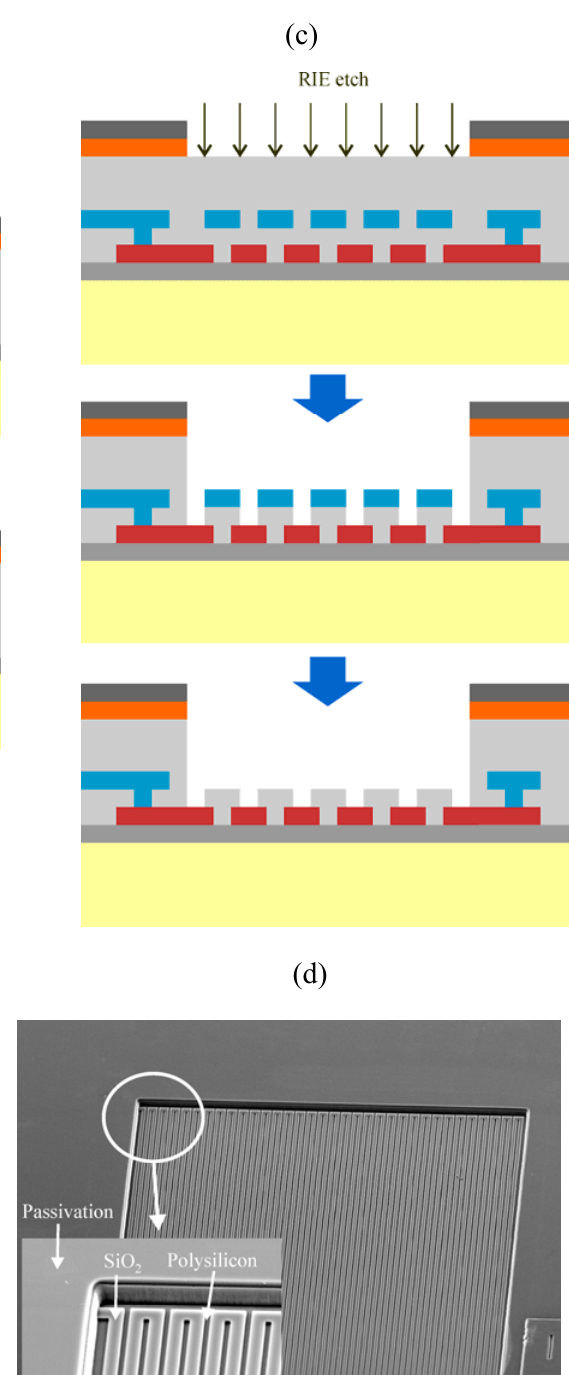
Figure 3. Post-process of the CMOS chip: (a) A simple RIE etch is used to expose the large polysilicon electrodes. (b) SEM image of the 4-electrode array. (c) To expose the interdigitated electrodes, a metal layer is used to protect the silicon oxide between fingers during the RIE etch. (d) SEM image of the interdigitated